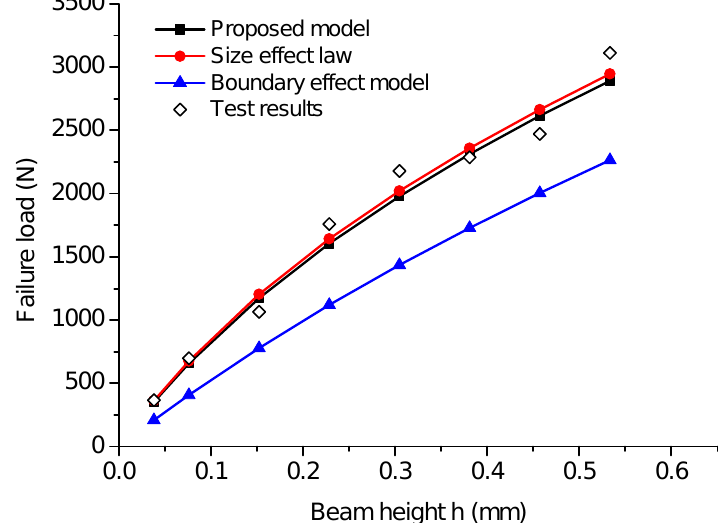
Figure 10. Model predictions of failure load versus beam height comparing with Type 2 SEL predictions, boundary effect model predictions and the test results of concrete.